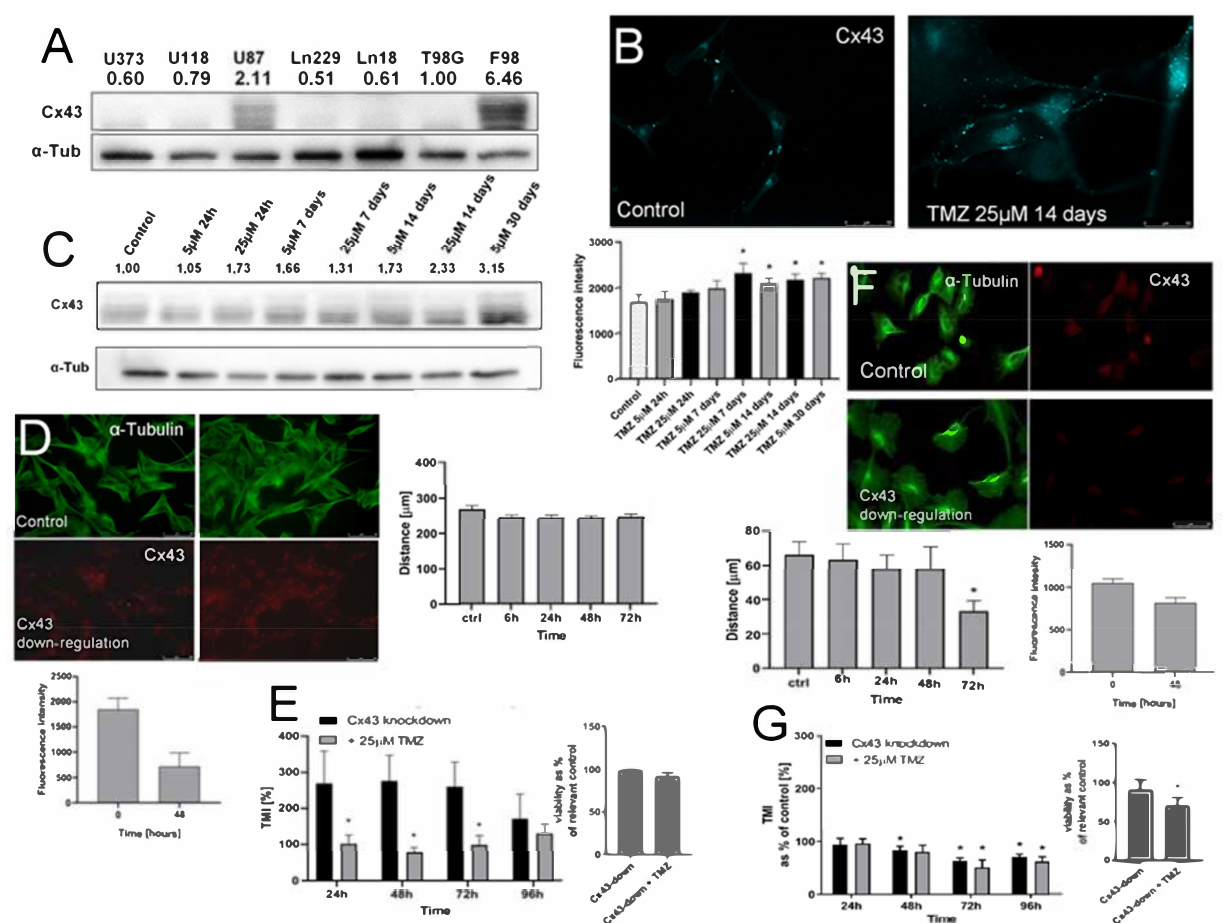
Figure 5. The effect of Cx43 down-regulation on the invasiveness of MGMT high and MGMT low cells. ( A ) Comparison of Cx43 levels in GBM cells estimated with immunoblotting. Numerical data show the density of Cx43-specific bands intensity calculated against the levels of α -tubulin as the housekeeping gene. ( B , C ) Effect of TMZ on the expression levels of Cx43 in U87 populations. Cells were treated with 5/25 µ M TMZ for up to 30 days and Cx43 levels were estimated with fluorimetry (( B ); see also Figure S4) and immunoblotting ( C ). Scale bar 50 µ m. ( D , E ) Effect of Cx43 silencing in U87 cells on their motility ( D ), transmigration through microporous membranes and their viability ( E ). Scale bar 50 µ m. ( F , G ) Effect of Cx43 silencing in T98G cells on their motility ( F ), and transmigration through microporous membranes and their viability ( G ). Scale bar 50 µ m. Statistical significance was calculated with ANOVA/non-parametric Mann–Whitney test, * p < 0.05 vs. control. Data are representative for three independent experiments. Note the sensitivity of T98G cells to ectopic Cx43